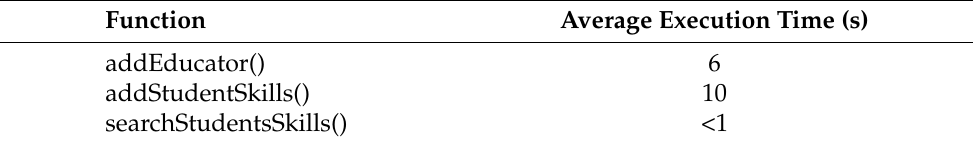
Table 3. Execution time per